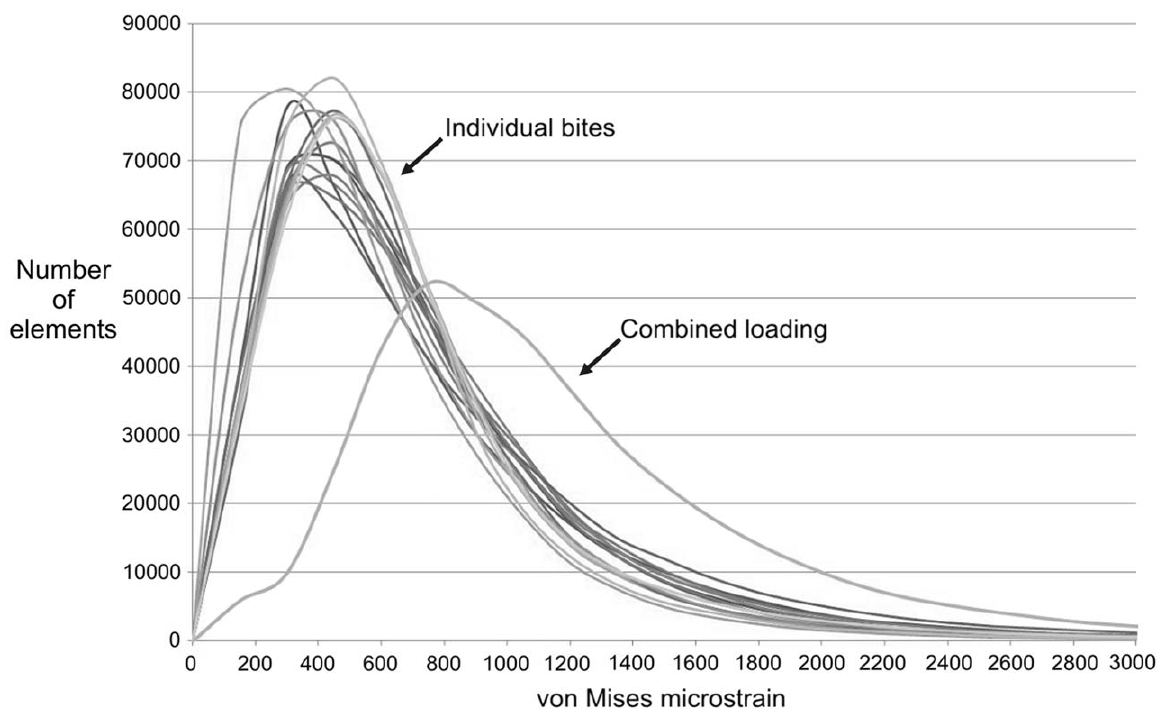
Figure 6. von Mises element strain distribution plots. Plot represents the number of elements within the finite element model that experience a specific strain magnitude. The plot shows the element strains from all fifteen biting simulations (labelled individual bites) and the combined loading model.